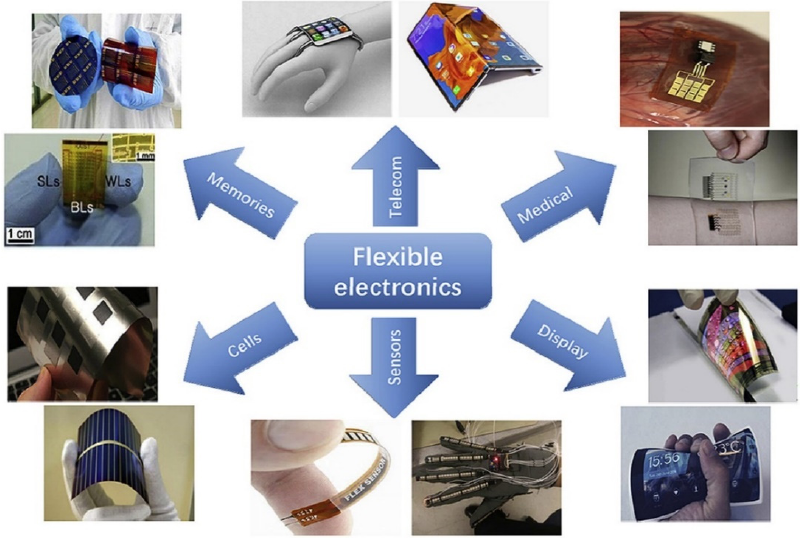
Figure 2. Application areas for flexible electronics. Reprinted with permission from Ref [9].